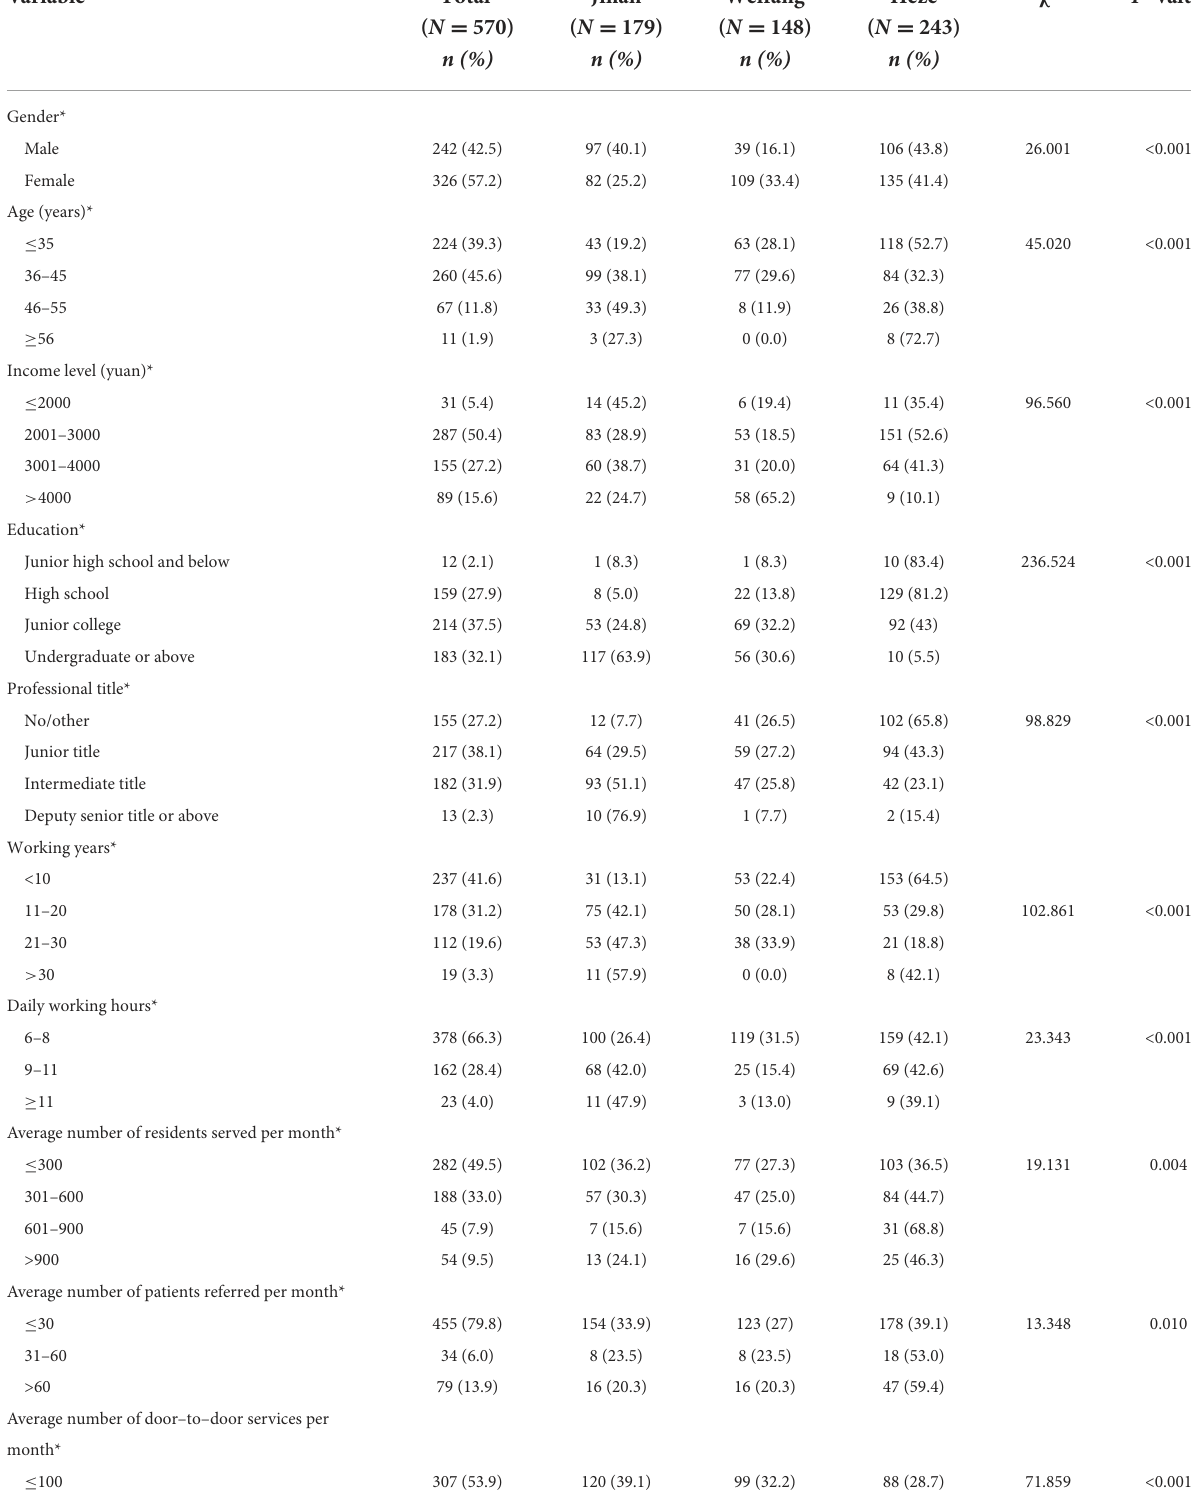
TABLE 1 Basic characteristics information of FPTMs